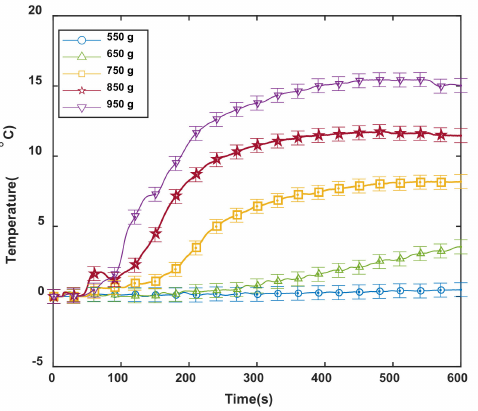
Figure 6. Variation in degree of subcooling over time with refrigerant charge